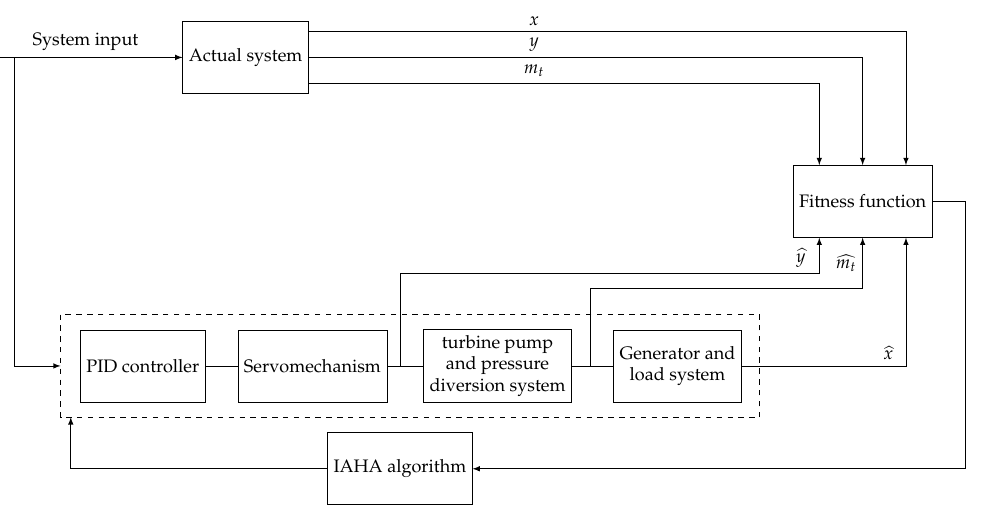
Figure 6. Identification strategy of the governing system.